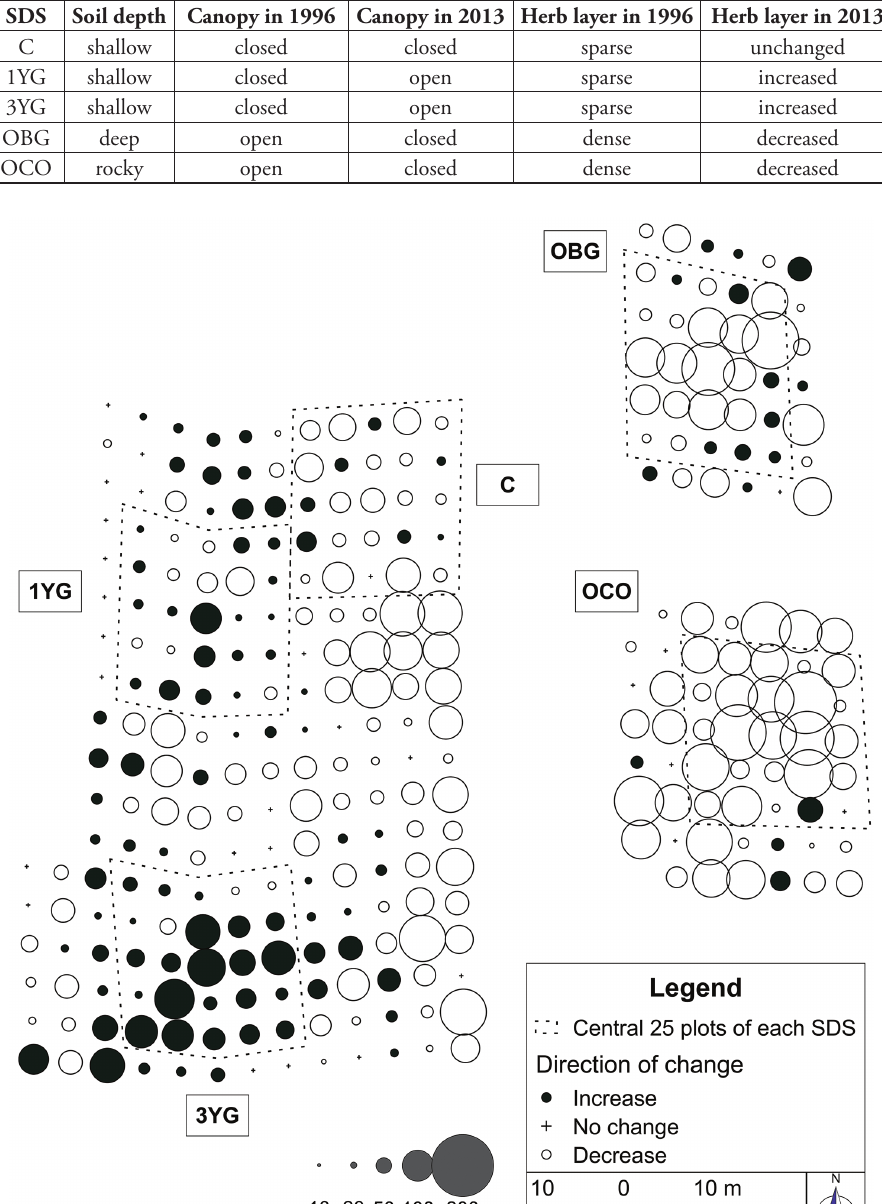
Table 1. Summary information on the five stand developmental situations (SDS) studied. For explana- tions of the stand developmental situations, see methods.